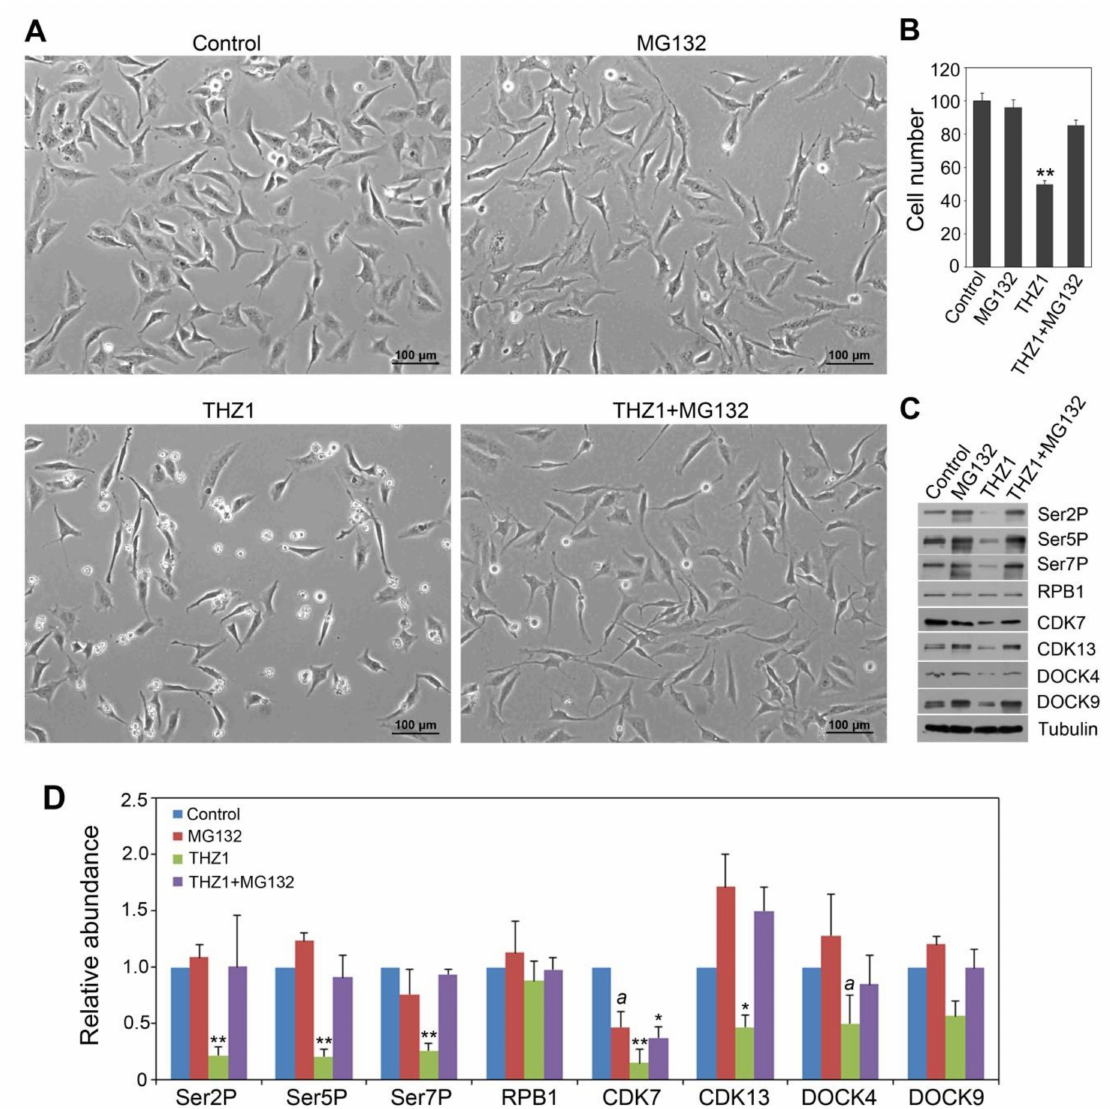
Figure 4. Suppression of the THZ1 e ff ects by MG132 treatment in HeLa cells. ( A ) Cells after 8 hr-treatments of 100 nM THZ1 and 40 µ M MG132. ( B ) Quantitative analysis of cell number after treatments. Cell number for the control average is set as 100, and all other treatment groups are normalized to the control. Values are means and SEM of six replicates, with ** indicating significant di ff erence between THZ1 and three other groups ( p < 0.01). ( C ) Western blot showing the e ff ect of THZ1 suppressed by MG132. Tubulin, the protein loading control. ( D ) Quantitative analysis of the Western blot results from two independent biological replicates. Protein level in the control was set as 1.0. Significance level is indicated by * ( p < 0.05) or ** ( p < 0.01) vs. control. The letter a above the column indicates a marginal di ff erence ( p < 0.10) compared to